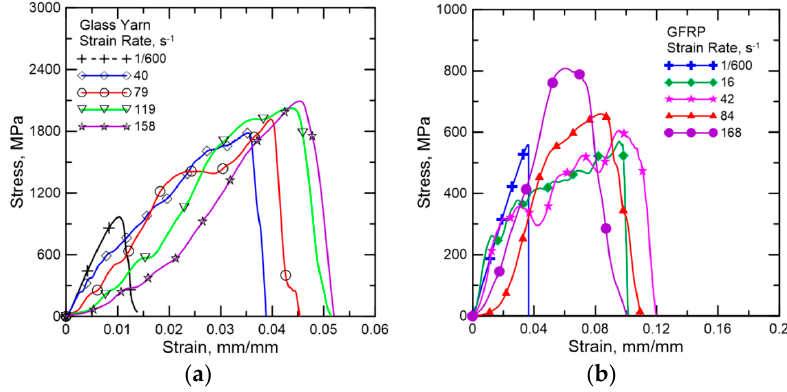
Figure 4. Representative stress–strain responses of ( a ) glass yarn at initial strain rates of 1/600, 40, 80, 120, 160 s − 1 and ( b ) GFRP at initial strain rates of 1/600, 25, 50, 100, 200 s − 1 .